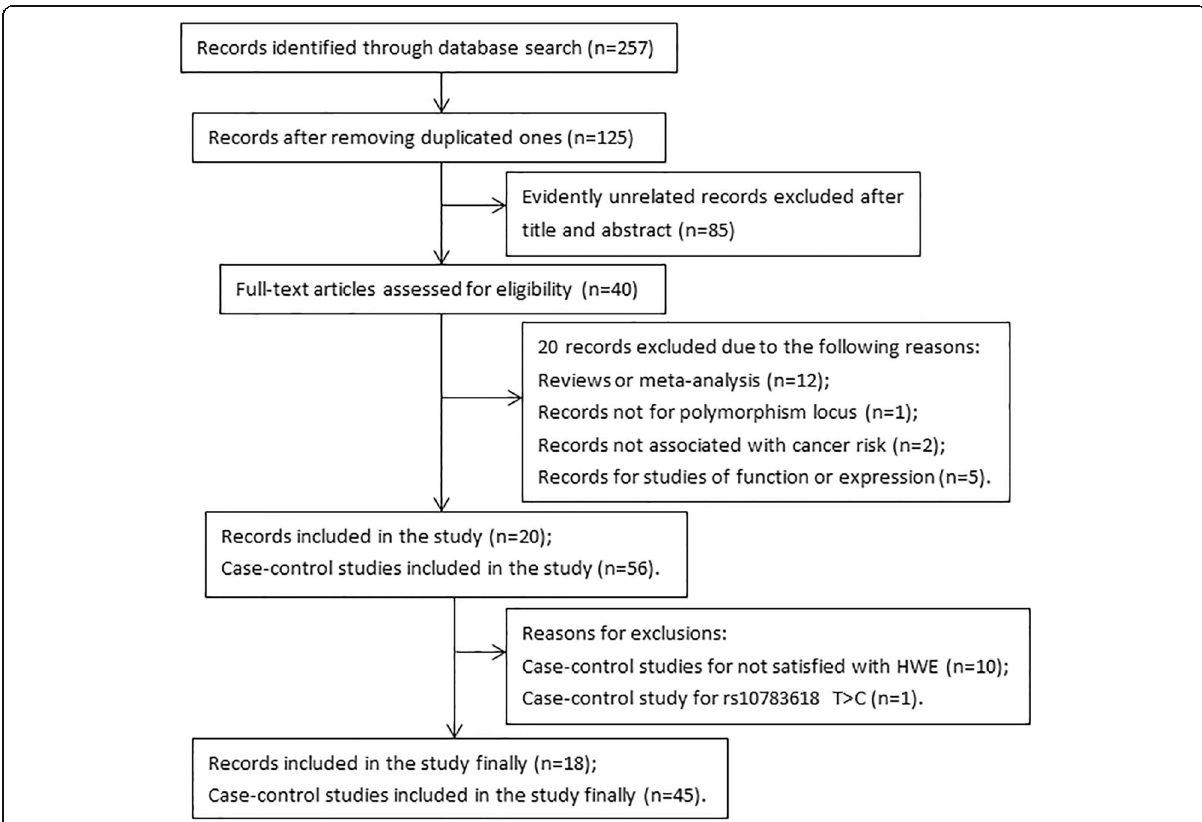
Fig. 1 Flow diagram of articles identified with included and excluded